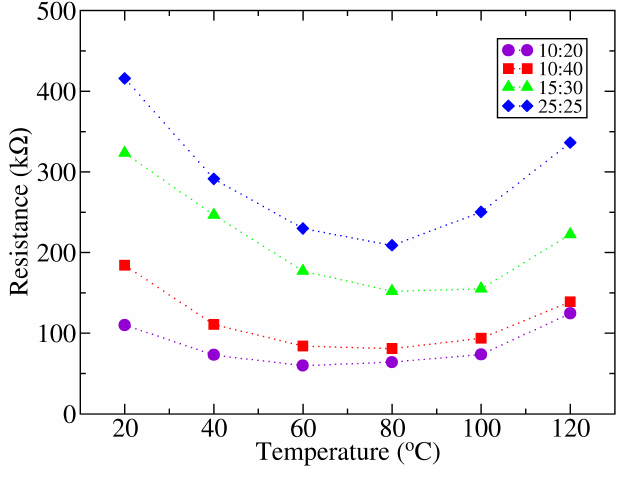
Figure 4. Resistance evolution of photodetectors as a function of temperature. The dotted lines are guides for the